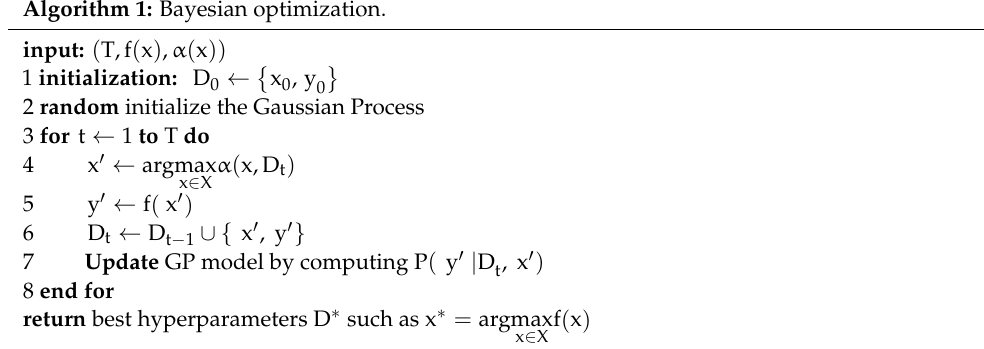
Algorithm 1: Bayesian